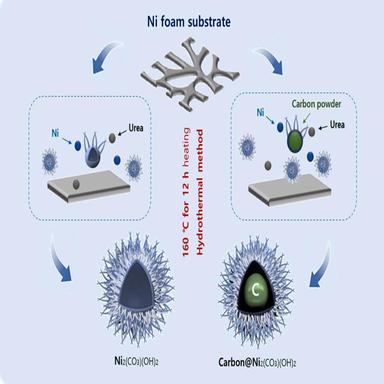
Schematic of the hollow Ni2(CO3)(OH)2 and core-shell carbon@Ni2(CO3)(OH)2 compounds on the Ni foam.